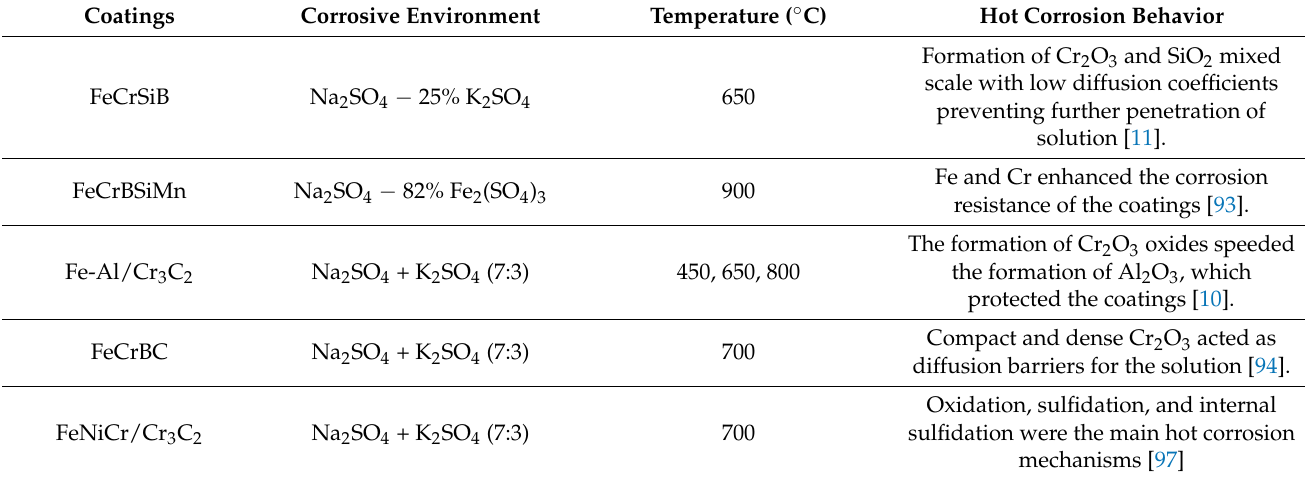
Table 6. Summary of the hot corrosion behavior of arc-sprayed Fe-based